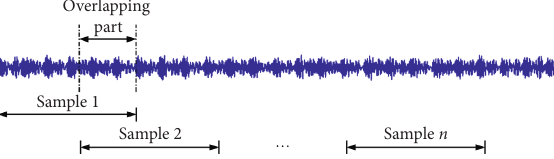
Figure 14: Schematic diagram of sample segmentation. Table 5: Number of samples and sample labeling